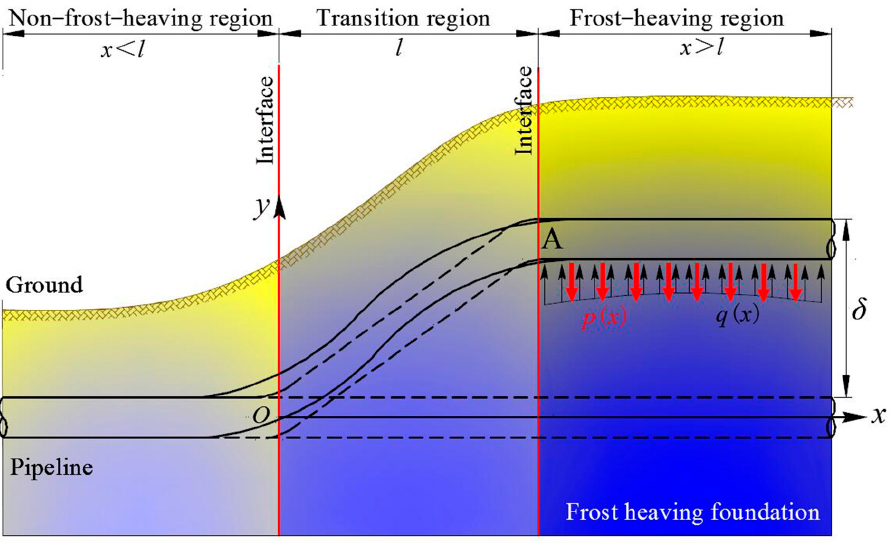
Figure 1. The stress diagram of pipe under frost heaving.